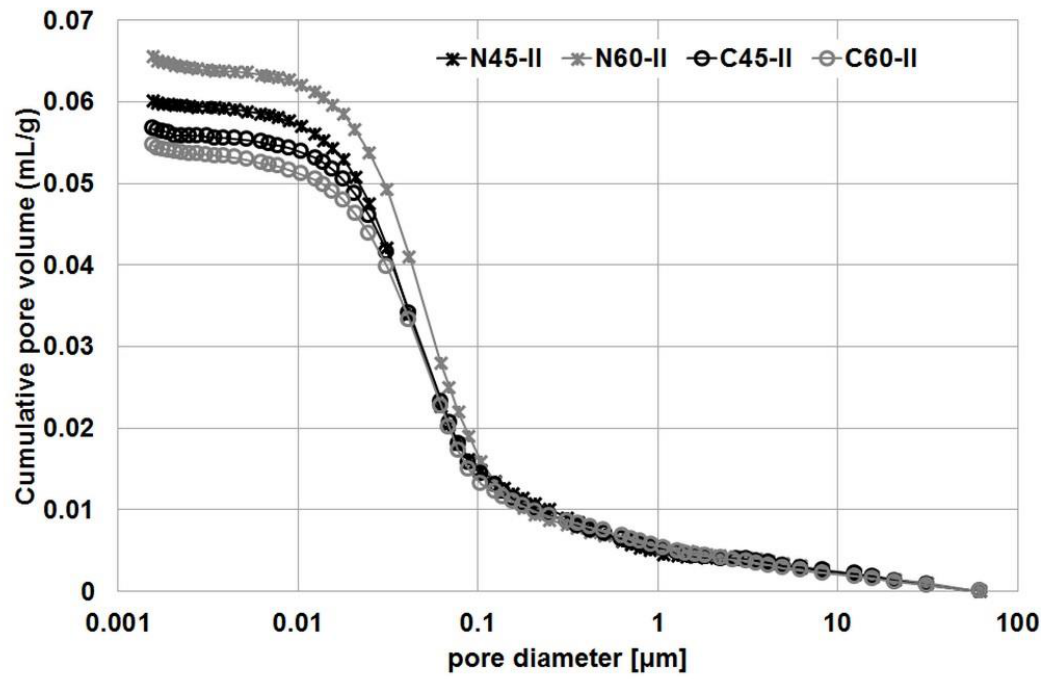
Figure 5. Cumulative pore distribution in R45-II and R60-II series.